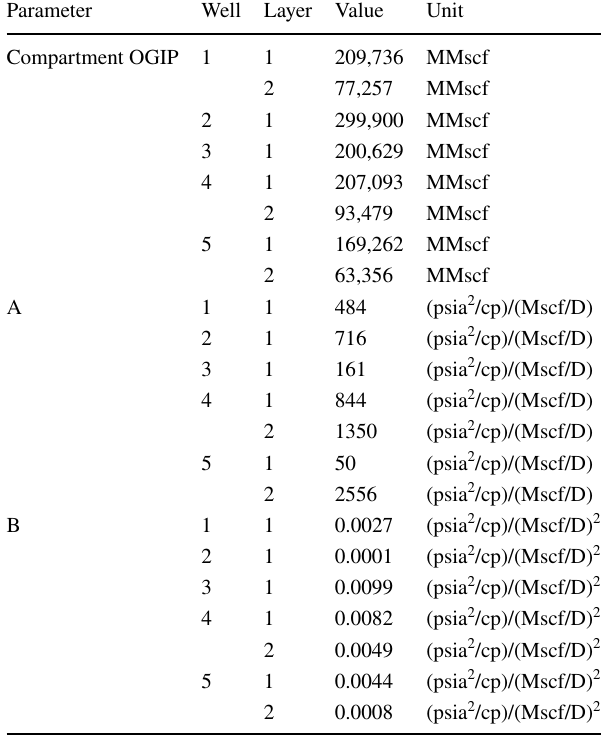
Table 2 Matching parameters for field case 1 Parameter